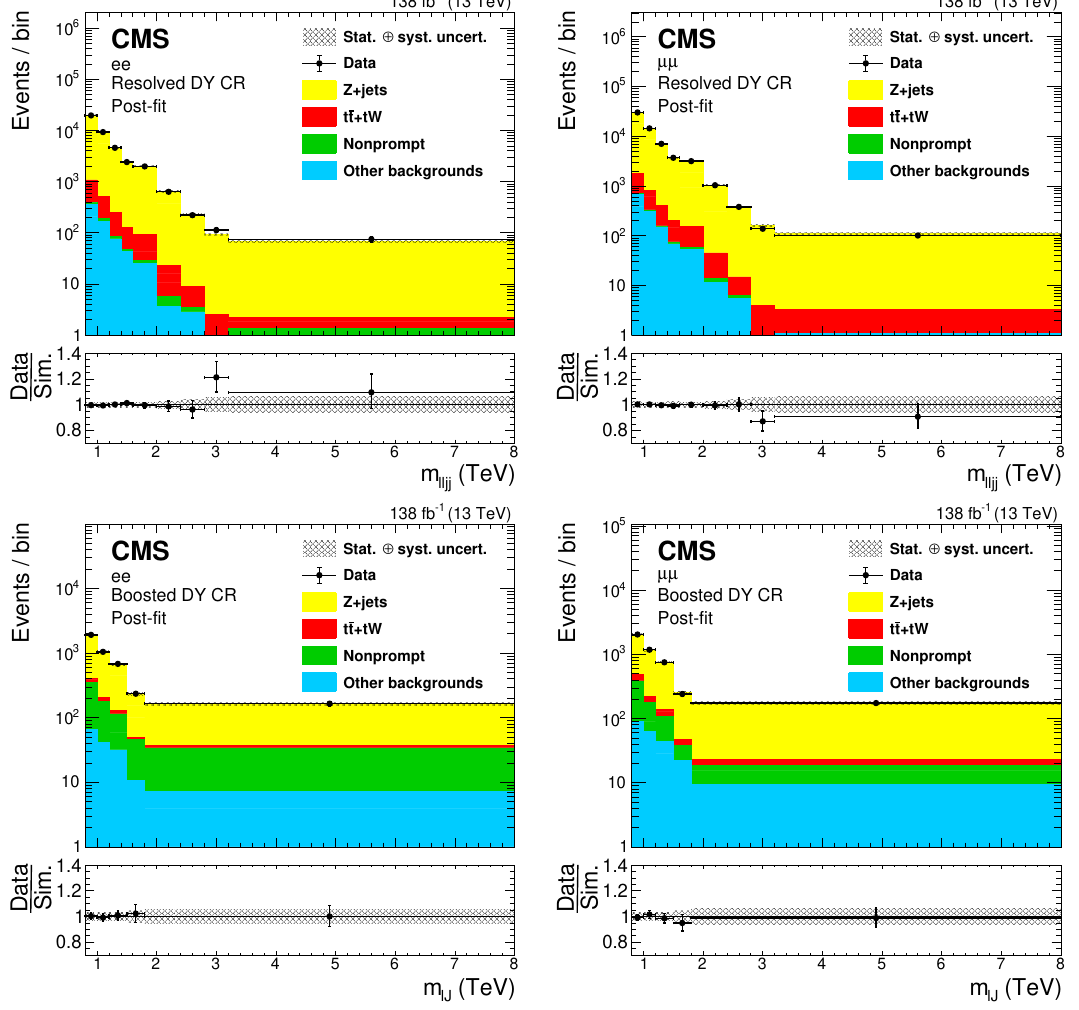
( m ) distributions in the resolved (boosted) DY CRs are shown in the upper Figure 3 . The m ‘‘ jj ‘ J (lower) row. Results in the ee ( mm ) channels are shown in the left (right) plots. The hatched uncertainty bands on the simulated background histograms include statistical and systematic com-